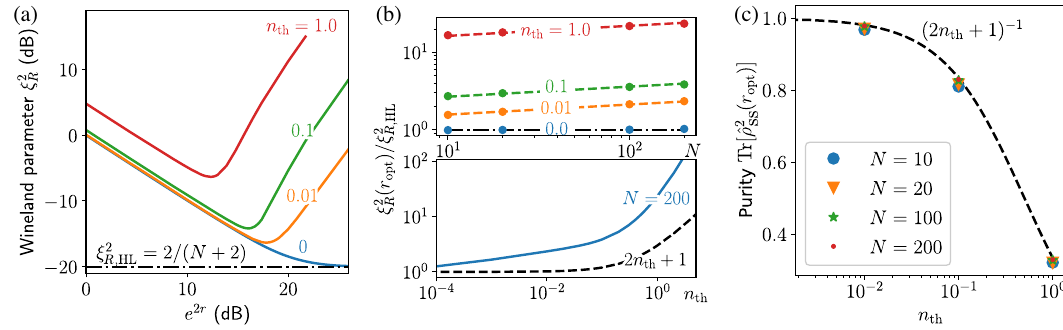
FIG. 8. (a) Steady-state Wineland parameter [obtained by numerically solving Eq. (29)] if the engineered reservoir stabilizes an impure squeezed state for N ¼ 200 and different effective thermal steady-state occupation numbers n indicates the Heisenberg limit ξ 2 ¼ 2 = ð N þ 2 Þ . For e 2 r ≪ N , the Wineland parameter follows the bosonic theory (30); i.e., spin R; HL squeezing is quite robust to n , and the Wineland parameter decreases with r . However, beyond an optimal squeezing strength r th ≪ 1 deteriorates squeezing quite strongly, and the Wineland parameter increases with r . a small effective thermal occupation n th > 0 and its ideal Heisenberg-limited value ξ 2 (b) Ratio between the minimum Wineland parameter for n th Top panel: ratio as a function of N . The dashed fitted lines indicate a N 0 . 13 scaling. Bottom panel: ratio as a function of n which clearly deviates from bosonic relation (30) indicated by the dashed black line. (c) Purity of the steady state of Eq. (29) at r , which closely follows the purity of the corresponding bosonic squeezed state (dashed black line) if Eq. (29) is mapped function of n th onto bosonic dissipative squeezing using a Holstein-Primakoff